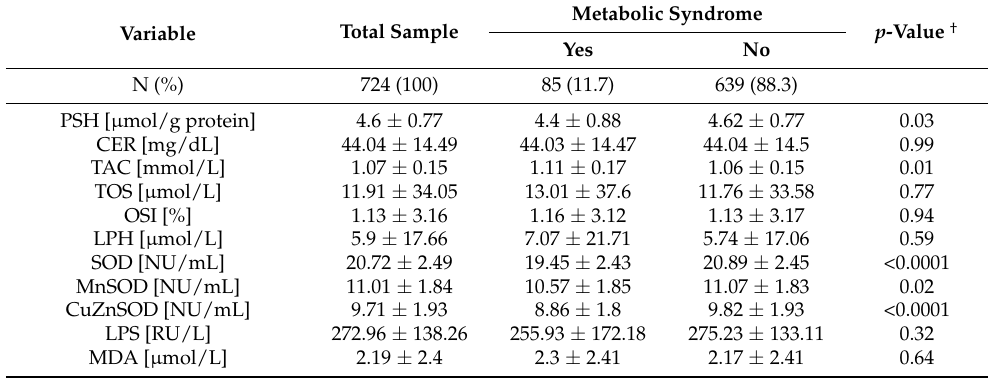
Table 3. The comparison of OS parameters between young adult patients with and without